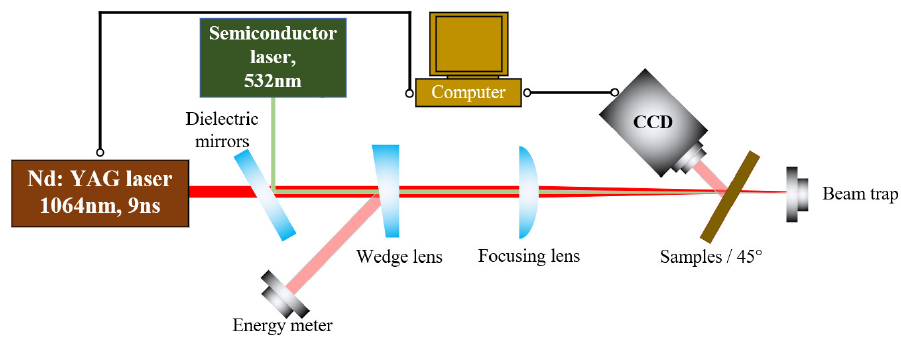
Figure 1. The layout of the working